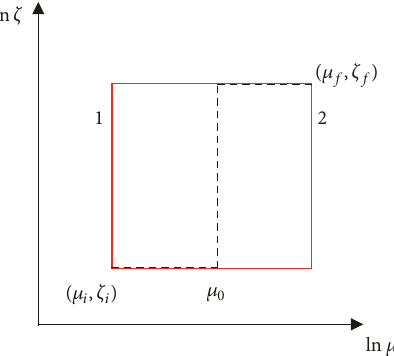
Figure 2: Paths for the improved D solution which depend on the choice of the reference scale 𝜇 0